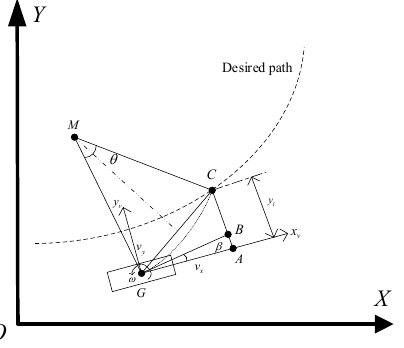
Figure 3. Vehicle trajectory prediction model under constant yaw rate.